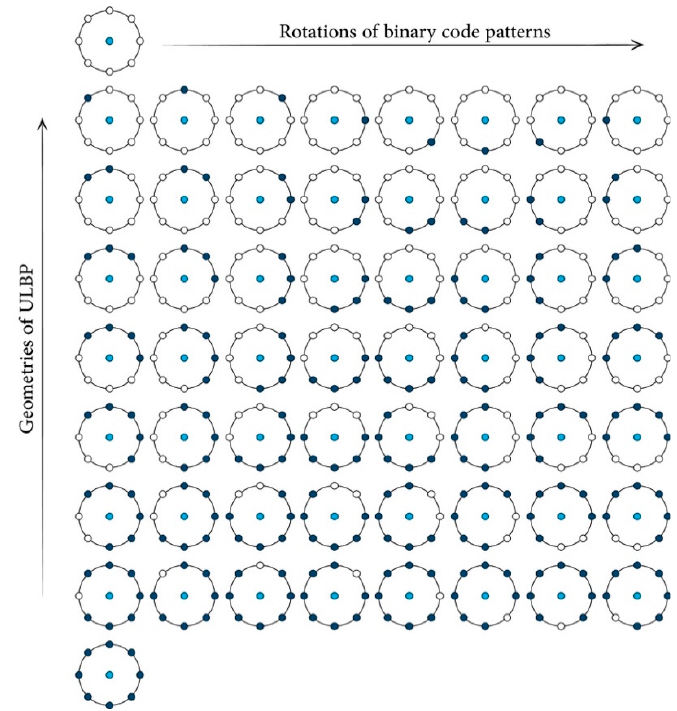
Figure 2. Geometric representation of the ULBP method. We can select one or more of these geometries to select landmarks from digital mam- mograms to construct PD. Different rows correspond to different types of texture. For ex- ample, the first and the last row correspond to flat and spot texture, row 5 (4 ones in the binary code) corresponds to edges and row 6 corresponds to corners. For example, candidate landmarks are central pixel positions of the first rotation of 𝐺 (cid:2869) (𝑅 (cid:2869) ) if a 3-by-3 patch’s binary code is 00000001 where 𝑅 (cid:2974) refers to rotations of specific 𝐺 (cid:3090) for 𝜉 = 1, 2, … , 8 . We followed the same strategy to select a set of pixel value locations for each of the 56 ULBP geometries depicted in Figure 2. The first two stages of Figure 3 show an example of a set of landmark pixel locations extracted from a normal and abnormal mammogram and their corresponding PDs. After selecting a set of mammogram pixel landmarks, we generated a Euclidean distance matrix 𝐷 from these pixel value locations, which will then be used as input for the PH generation pipeline.